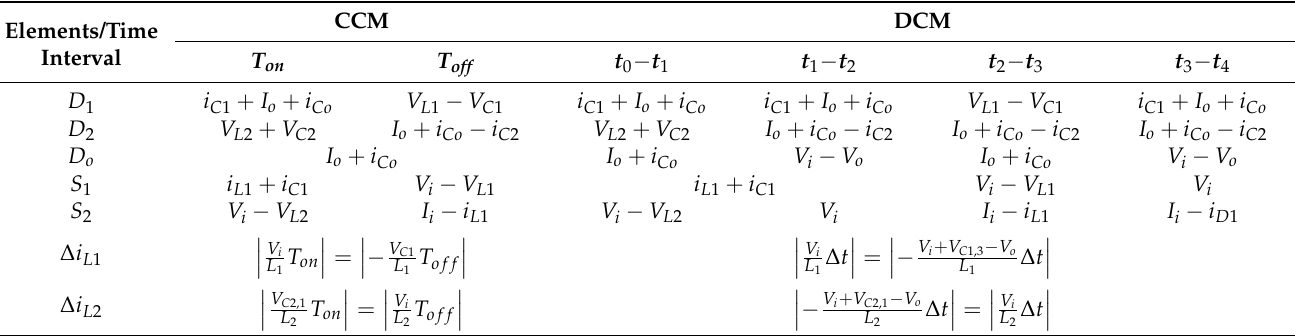
Table 1. Comparison between proposed converter and the existing topologies.